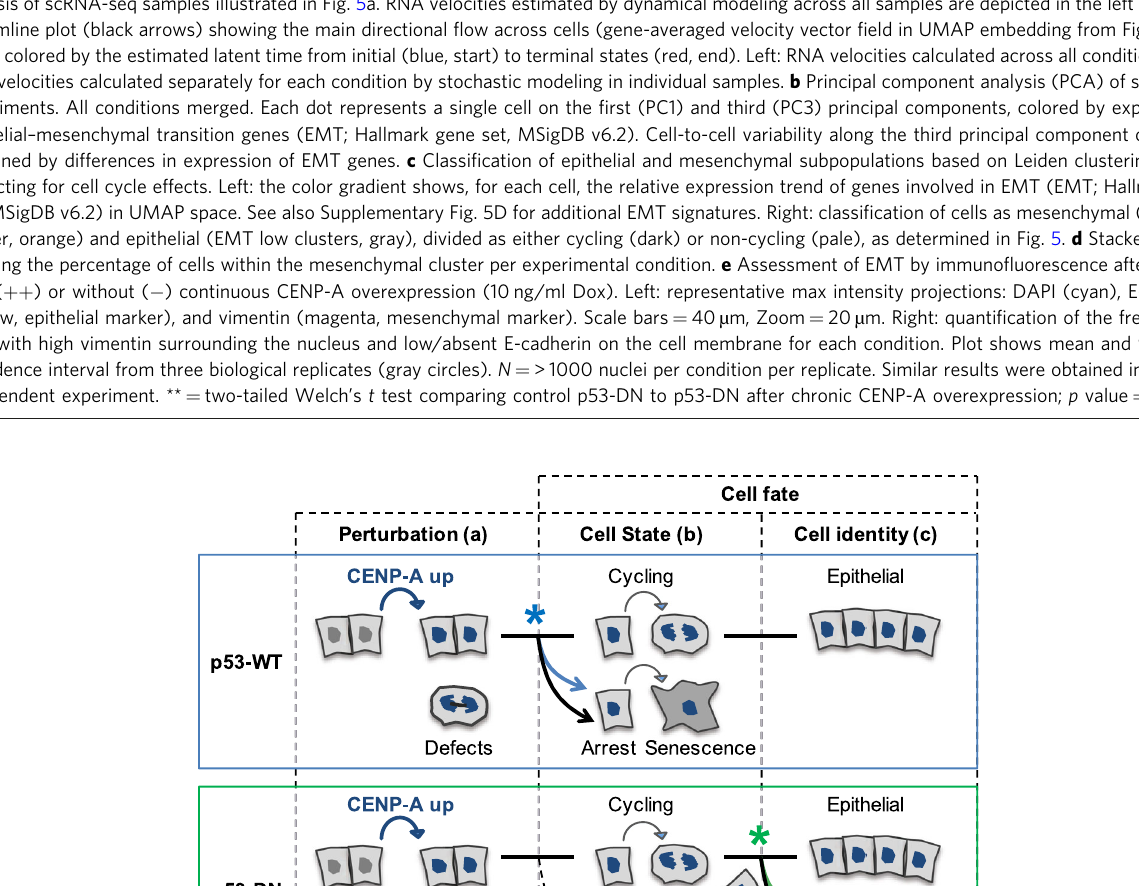
Fig. 7 CENP-A overexpression promotes distinct cell fates depending on p53 status. CENP-A overexpression reprograms cell fate with distinct effects on cell state and cell identity that depend on p53 status. Perturbation ( a ) by CENP-A overexpression (in blue) induces mitotic defects in both wild-type p53 (p53-WT, top panel blue) and p53-defective cells (p53-DN, dominant negative, bottom panel green). These defects provoke distinct cell fate decisions according to p53 status, impacting cell state ( b ) or identity ( c ). When p53 is functional, cell state shifts toward acute cell cycle arrest and senescence, reducing self-renewal capacity. Additional stress, like DNA damage from X-irradiation, ampli fi es this response, resulting in radiosensitivity. Furthermore, functional p53 ensures the preservation of epithelial identity. In contrast, when p53 is defective, the cells evade arrest and continue cycling, allowing CENP- A overexpression to promote epithelial – mesenchymal transition (EMT). * symbol: reprogramming stimulated by CENP-A